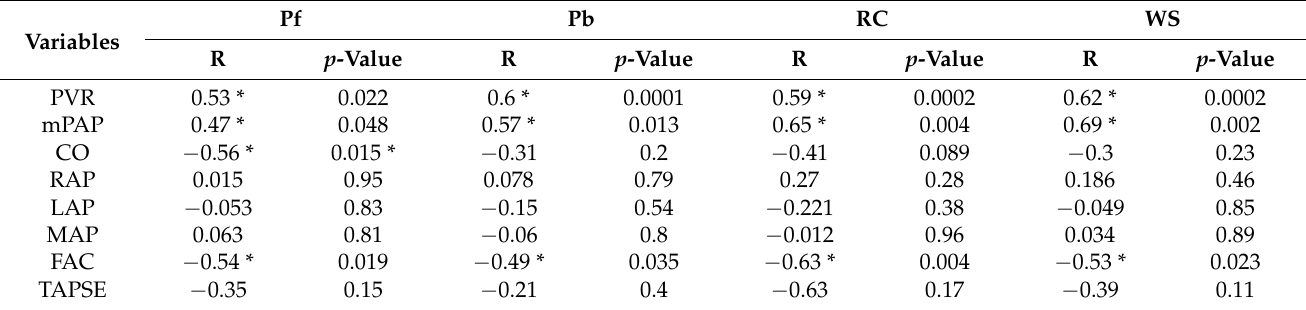
Table 2. Correlation between PAWR indices and hemodynamic and echocardiographic variables.